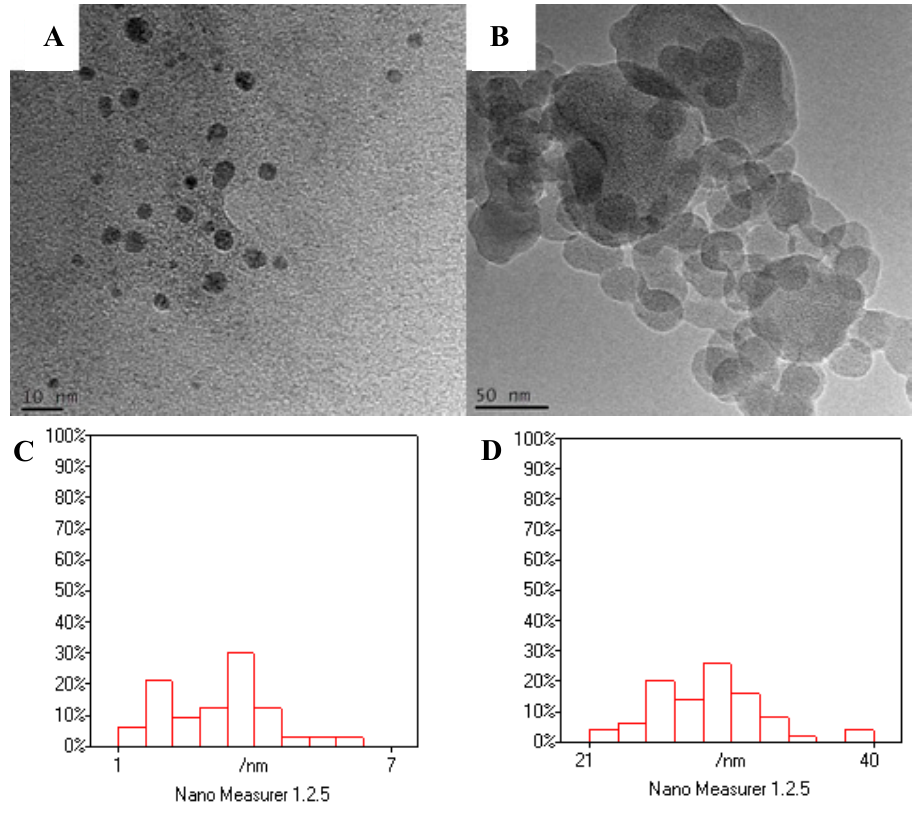
Figure 2. TEM images of Fe 3 O 4 NPs( A ); Fe 3 O 4 @Au@PDA MNPs ( B ); and particle size distribution diagram of Fe 3 O 4 NPs ( C ) with total 33 particles; Fe 3 O 4 @Au@PDA MNPs ( D ) with total 50 particles by Nano Measurer 1.2.5. The y -axis % represents the proportion of nanoparticles in a certain size range.